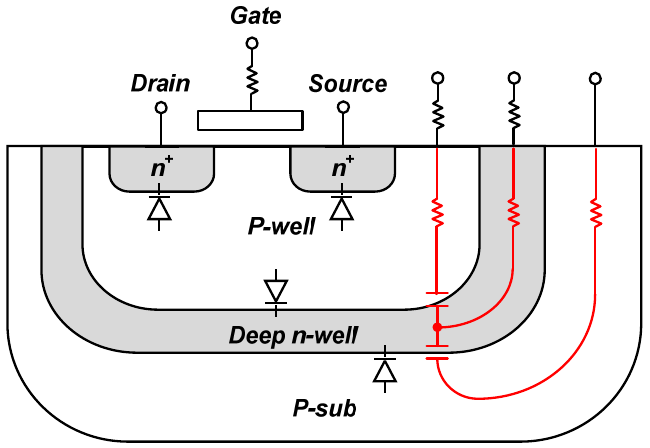
Figure 7. Cross-sectional view of an NMOS transistor in a deep n-well.